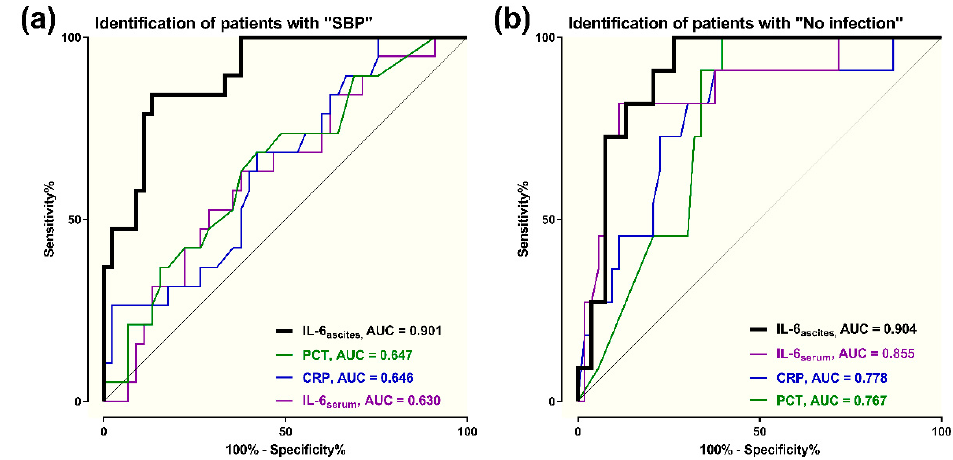
Figure 3. Diagnostic accuracy of baseline ascitic interleukin 6 (IL-6 ascites ), CRP, PCT, and IL-6 serum to ( a ) identify patients with spontaneous bacterial peritonitis (SBP) and ( b ) rule out clinically apparent infections (“ no infection ”).